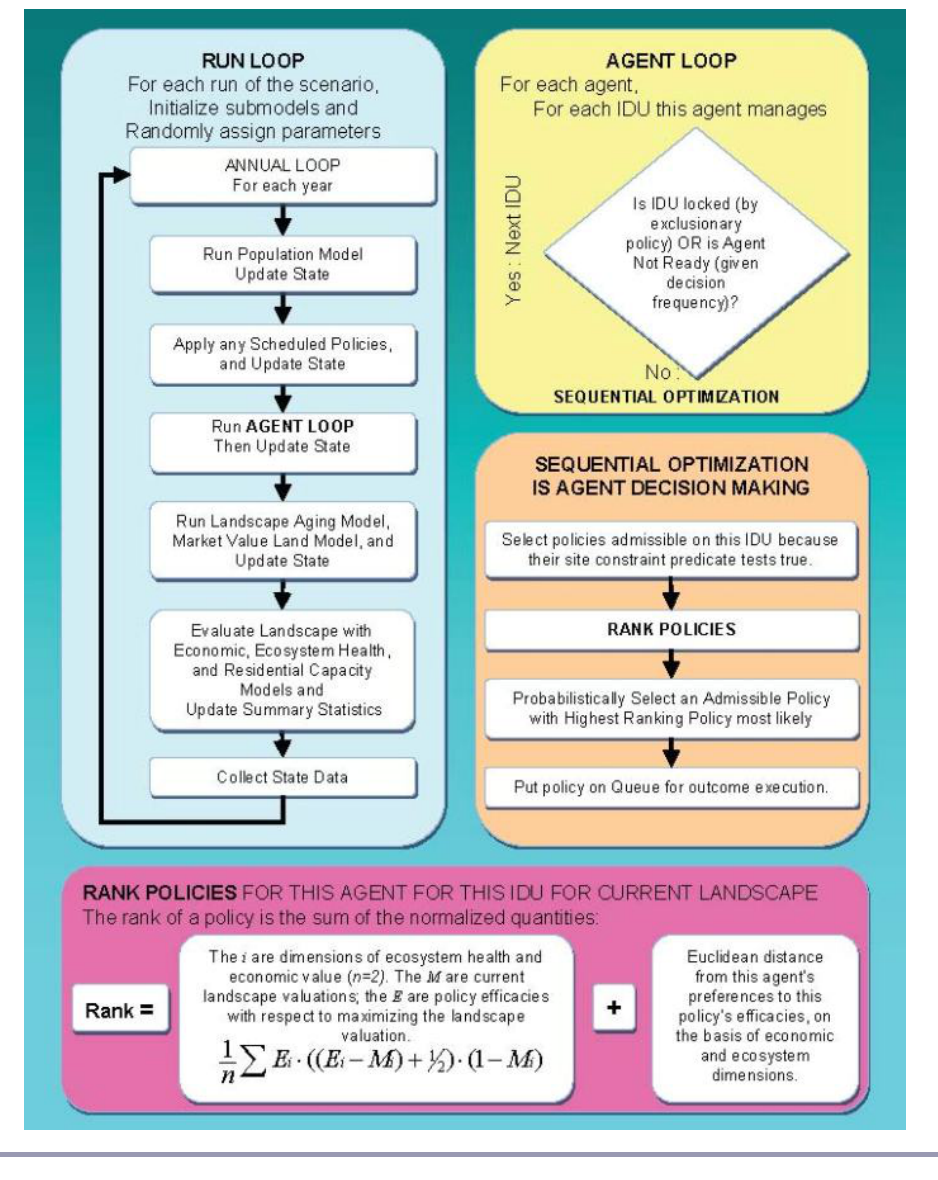
Fig. 3 . Process overview and scheduling for a scenario. A scenario is initialized by loading the policies and distributional information for the stochastic parameters that characterize the scenario. For each run of the scenario, the stochastic parameters are sampled from their distribution. The annual loop runs the agent loop and also the landscape evaluators and the environmental processes independent of agent behavior, including the population and vegetation succession models. Note that the policy ranking index has two components: One depends on agent preference, and the other on current landscape valuations for ecosystem health and economics. The latter component is proportionately larger according to the magnitude of landscape deficiencies or scarcities. The effect of annual executions of the agent loop is tantamount to stochastic sequential optimization for ecosystem health and economics. An IDU is an integrated decision unit or a polygon in the landscape managed by an